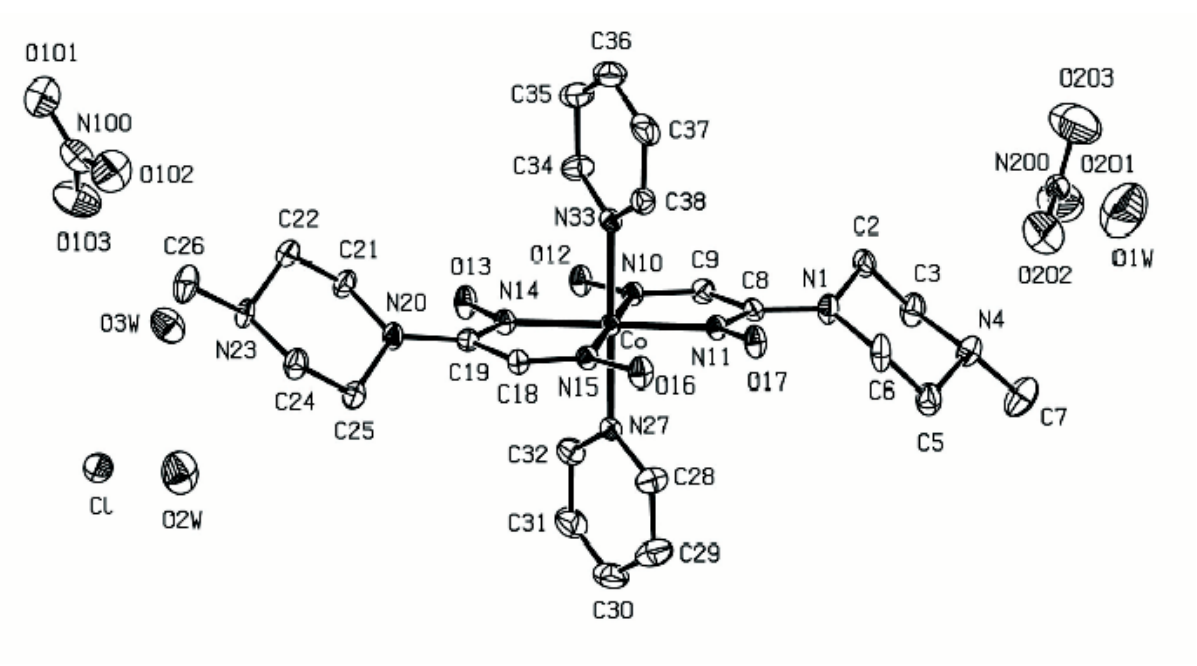
Figure 1. An ORTEP-II drawing with the numbering scheme and ellipsoids at the 50% probability